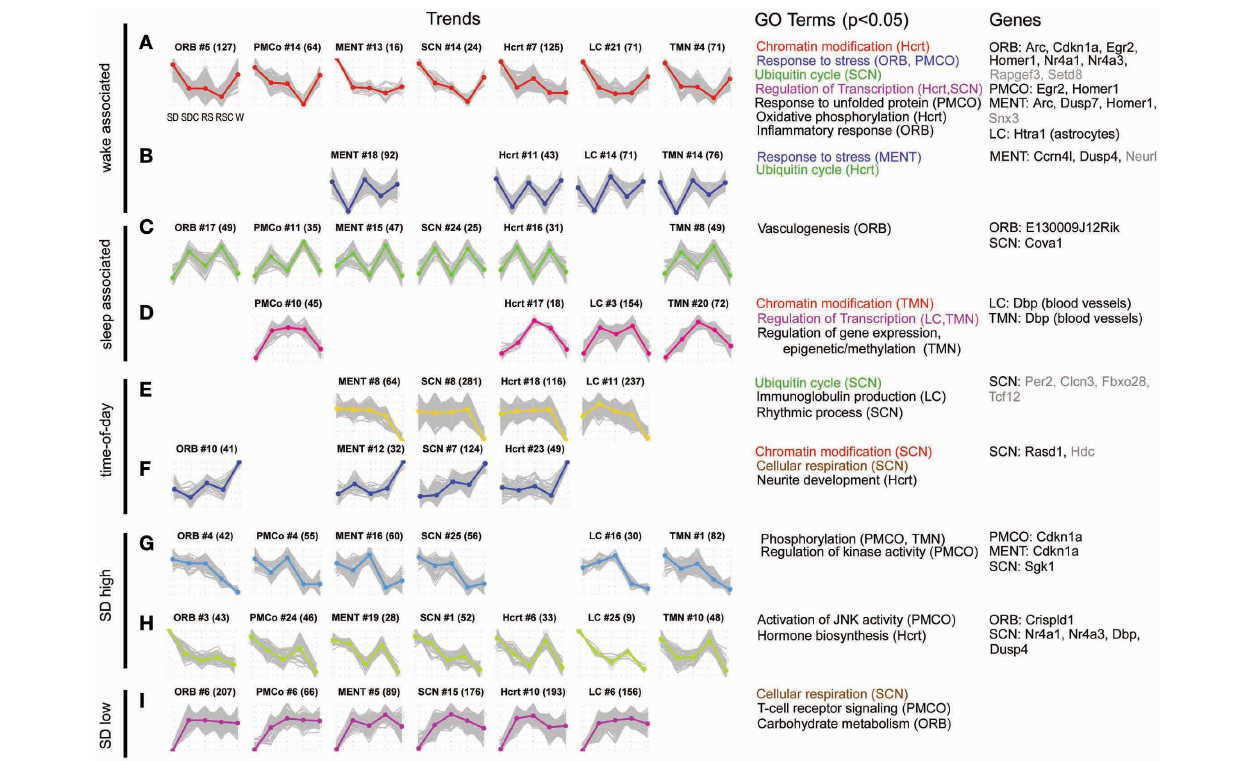
Figure 5 | gene expression showed a diversity of responses to time-of-day and treatment condition. Differentially expressed genes were identified by one-way ANOVA with a p -value cutoff of 0.05. For each identified gene, the expression values of four replicates were averaged and z-transformed (plotted on y -axis) and arranged to form a trend vector, with the expression values of the treatment groups plotted in the following order: SD, SDC, RS, RSC, and W [ x -axis of each trend; labels shown in the first plot in (A) ]. Hierarchical clustering was used to cluster differentially expressed genes into 25 trends per each of 7 regions, resulting in a total of 175 trends. For each cluster, the average expression trend of the cluster [plotted as colored, bolded line in (A–i) ] was extracted by averaging the individual gene trend